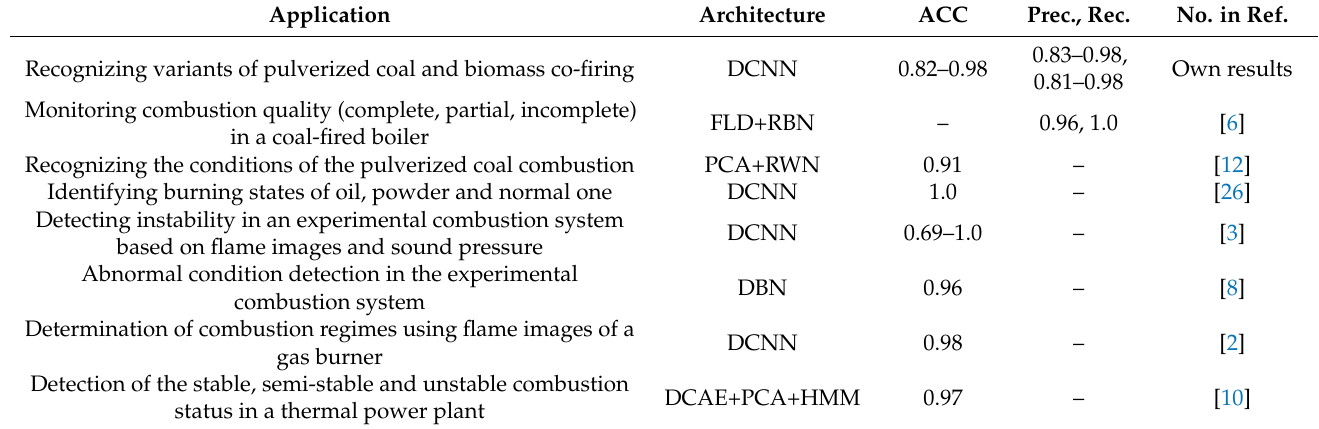
Table 6. Comparison of the classification results, where the subjects of study were flame images. Application Architecture ACC Prec., Rec. No. in